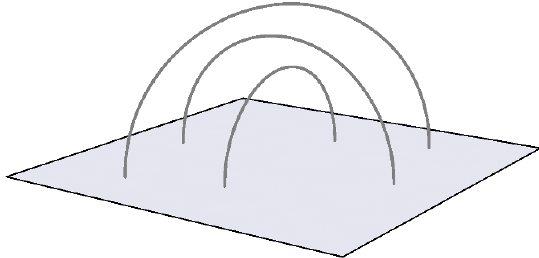
Figure 2. Examples of geodesics in the three-dimensional hyperbolic space H 3 . The shortest geodesic distances between two points on the plane scales logarithmically in the coordinate distance in the